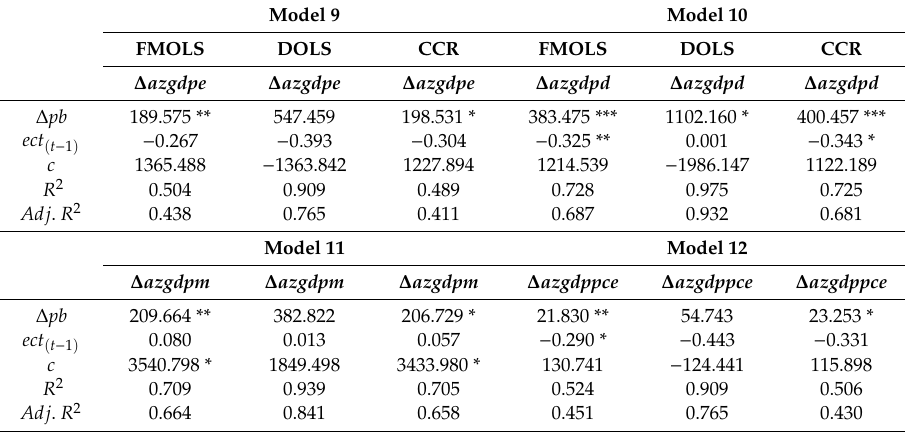
Table 10. The influence of oil price on macroeconomic indicators (Azerbaijan).